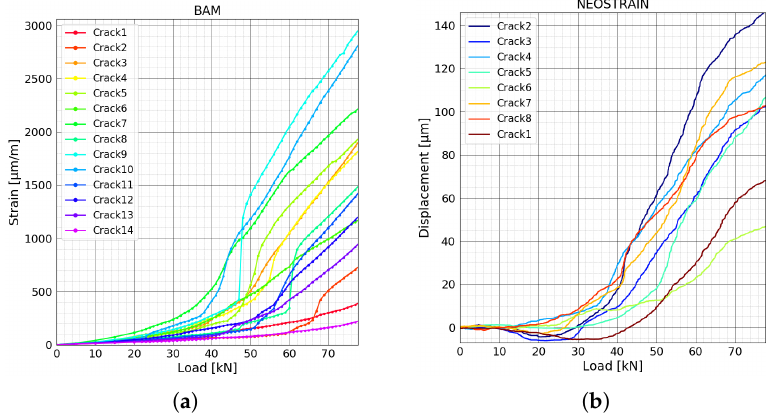
Figure 13. ( a ) Strain variation at position of all cracks measured by fiber line 7B at BAM. ( b ) Displacement at position of all cracks measured by DIC technique at